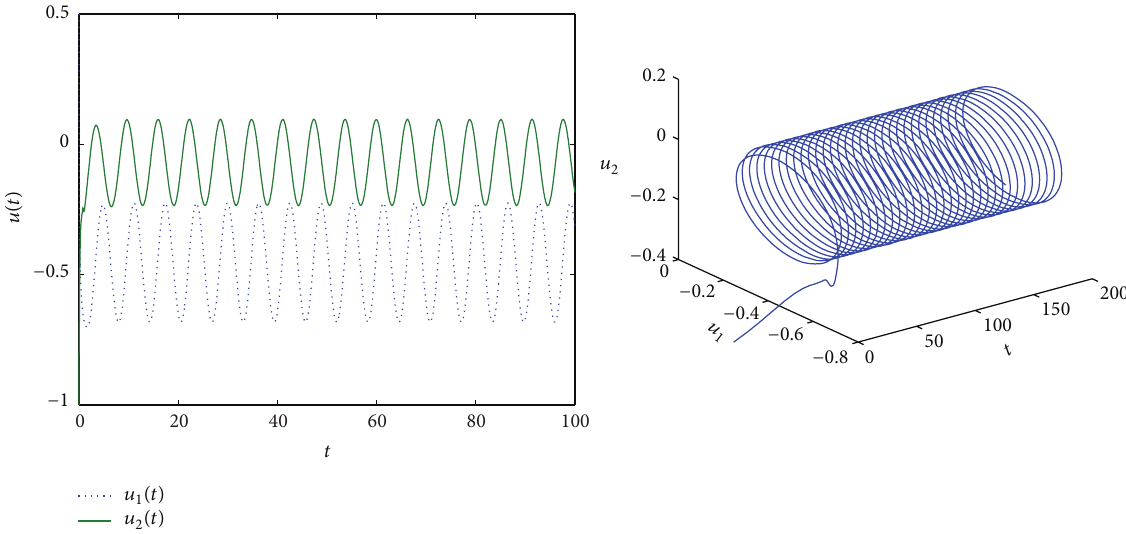
Figure 3: Time responses of the state variables 𝑢(𝑡) and phase plot in space (𝑡,𝑢 1 , 𝑢 2 )